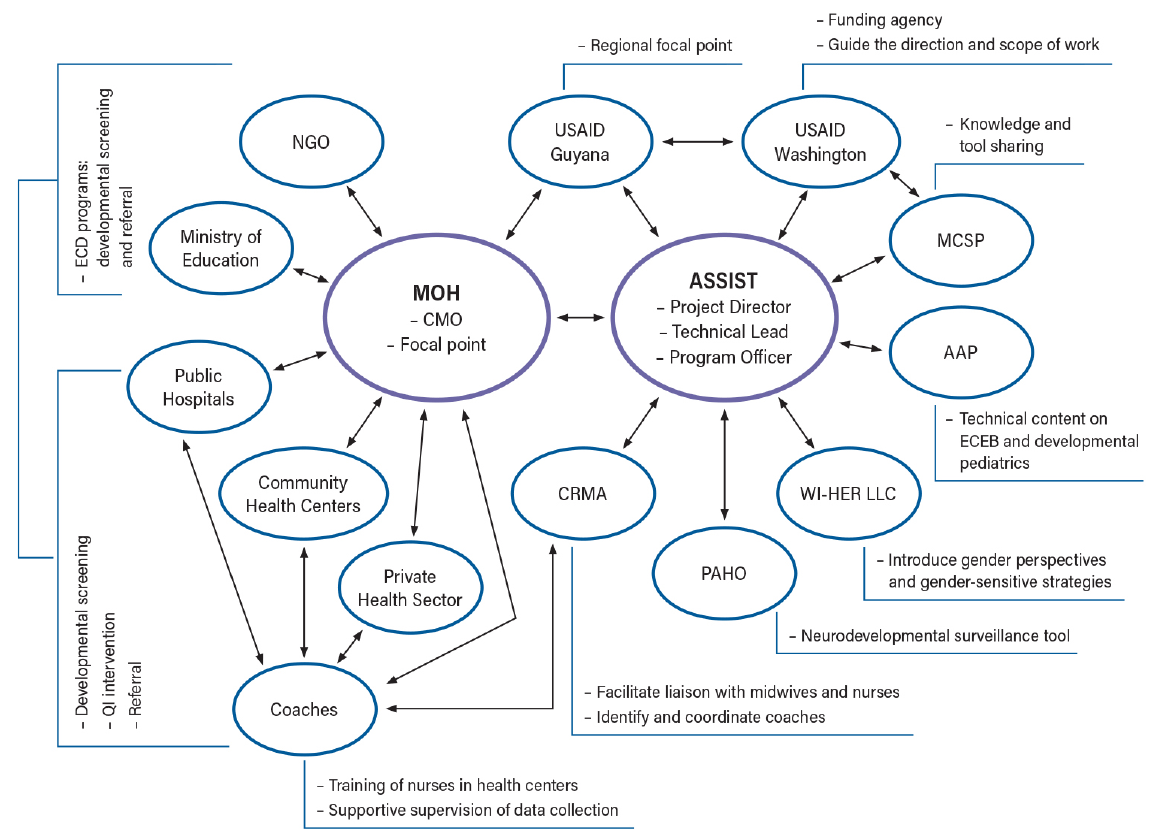
Figure 1. Map of stakeholders and communication/relationship linkages. Notes: The central part of the chart shows the country Ministry of Health as the principal technical assistance recipient and stakeholder and the USAID ASSIST Project as the leading provider and implementing partner of USAID. Key supporting implementing partners and other national stakeholders are arranged around the above two main stakeholders. Arrows reflect the relationship and communication flows between different stakeholders. Sidebars display the key roles each stakeholder played in the startup. USAID Guyana and CRMA are in the middle between the main stakeholders as regional liaisons and partners. MCSP, USAID Maternal and Child Survival Program; AAP, American Academy of Pediatrics; CRMA, Caribbean Regional Midwives Association; MOH, Ministry of Health; PAHO, Pan American Health Organization; CMO, Chief Medical Officer; WI-HER LLC, Women Influencing Health, Education, and Rule of Law; NGO, non-governmental organization; ECD, early childhood development; ECEB, essential care for every baby; QI, quality